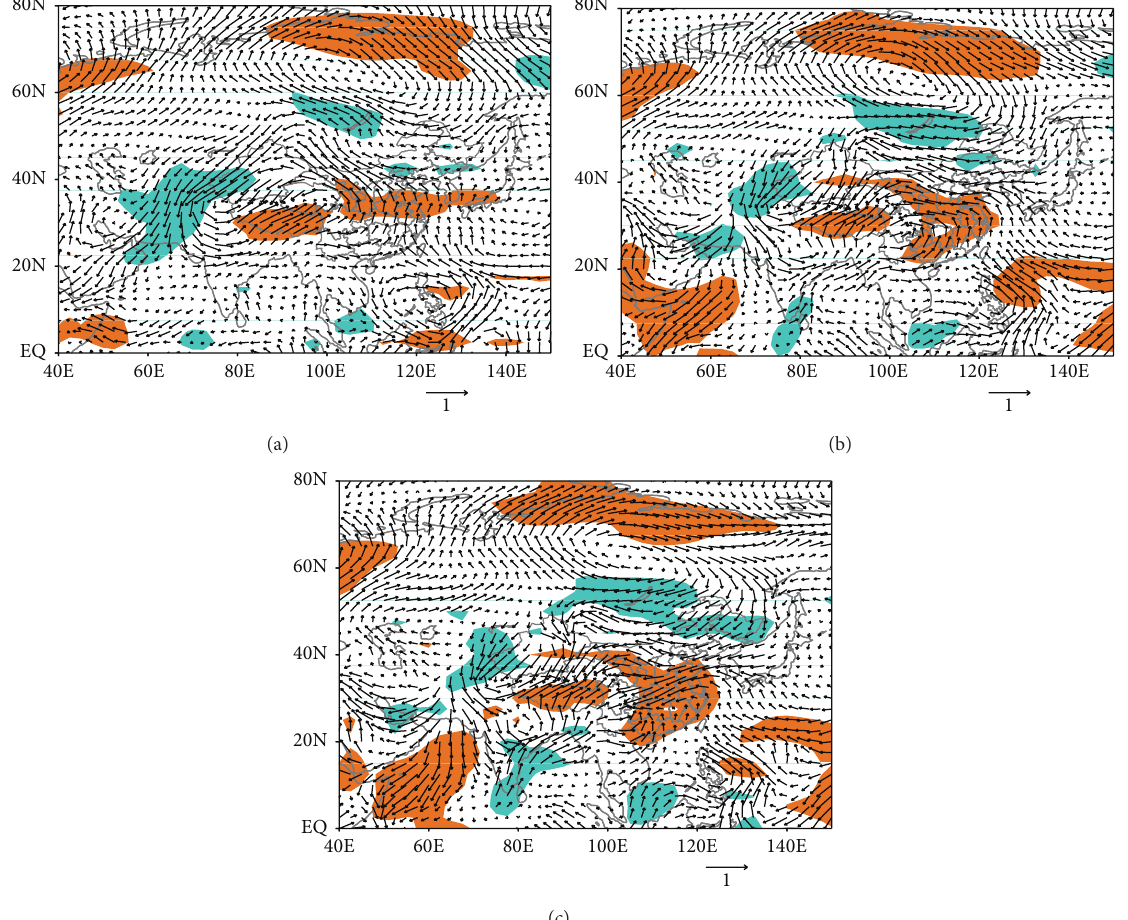
Figure 10: Correlations between the plateau surface heating anomaly and moisture flux anomaly and composited wind derived via correlation analysis between the plateau surface heating anomaly and the 𝑢 , V wind anomaly in January 2008 (the shaded area denotes correlation at the 95% confidence level, with the orange/blue colors indicating positive/negative